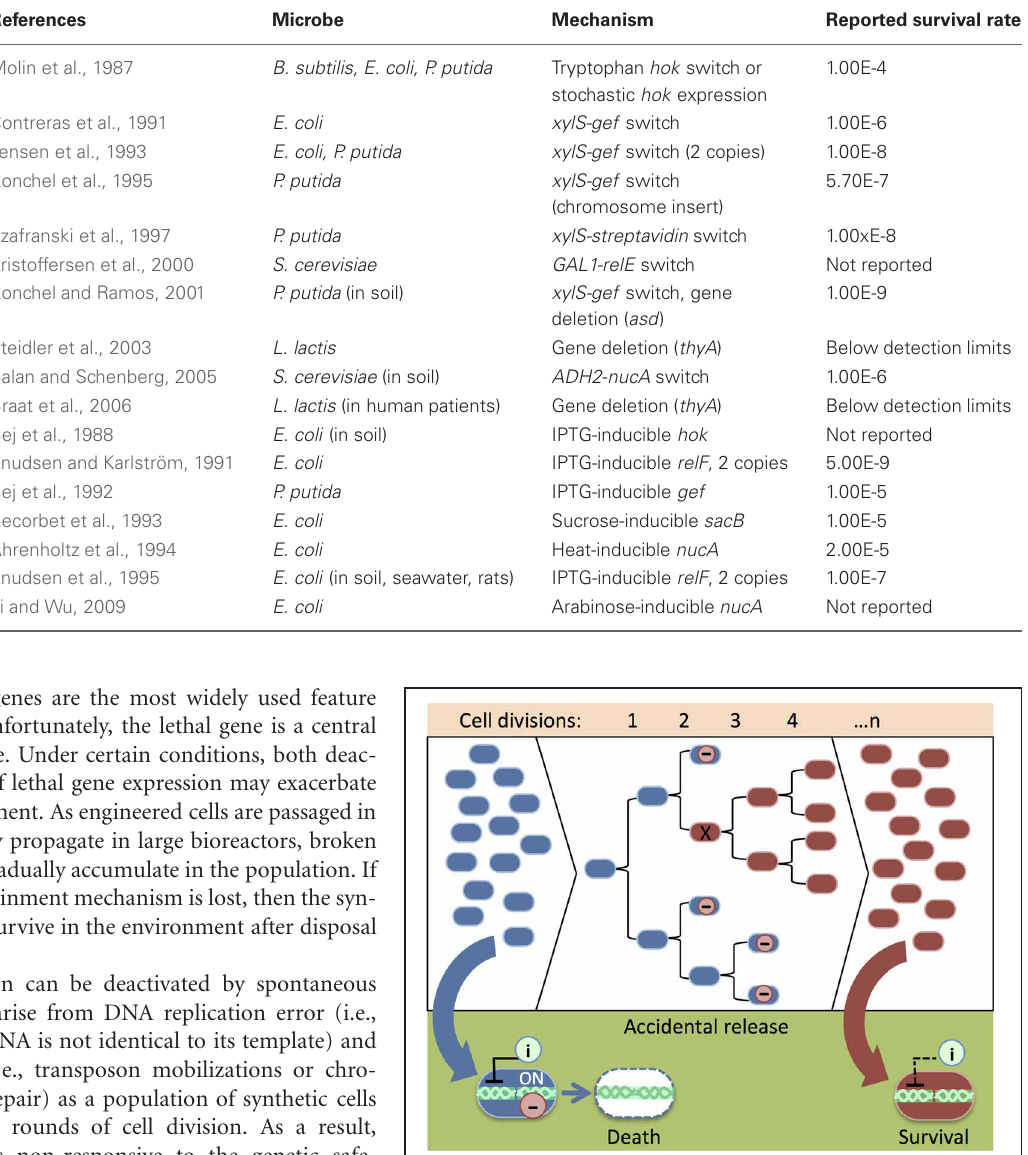
FIGURE 3 | An illustration of the accumulation of damaged genetic safeguards in a population of synthetic organisms. When cells with intact safeguards (blue) escape physical containment (e.g., an accidental spill), an inducer (i) can be added to remove them from the environment (see Figure 1C ). As the population grows, leaky expression of the lethal protein ( − ) reduces the viability of cells that carry functional safeguards. Mutation (X) of the lethal gene provides a growth advantage, thus cells that carry damaged safeguards (red) overwhelm the population. Cells with mutated safeguards do not respond to the cell death inducer (i). Consequently, it is difficult to remove the cells from the environment after an accidental